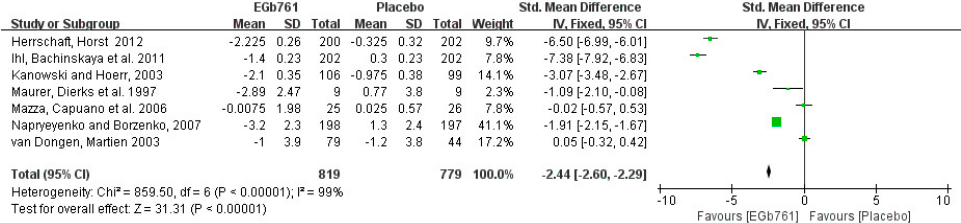
Figure 5. Forest plot for comparison: GBE treatment versus vehicle treatment. Outcome: escape latency in the probe test of MWM. The square area represents the weight assigned to the study in the meta-analysis. The horizontal line represents the 95% confidence interval.